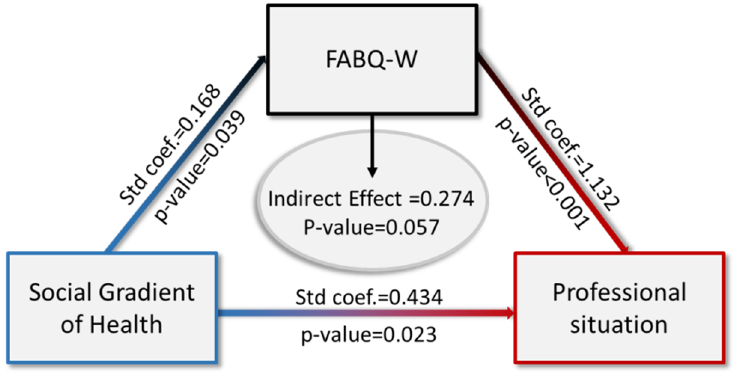
Figure 1. Structural equation model of the mediation effect of the Fear-Avoidance Belief Questionnaire Work subscale score on the effect of Social Gradient of Health on professional situation.